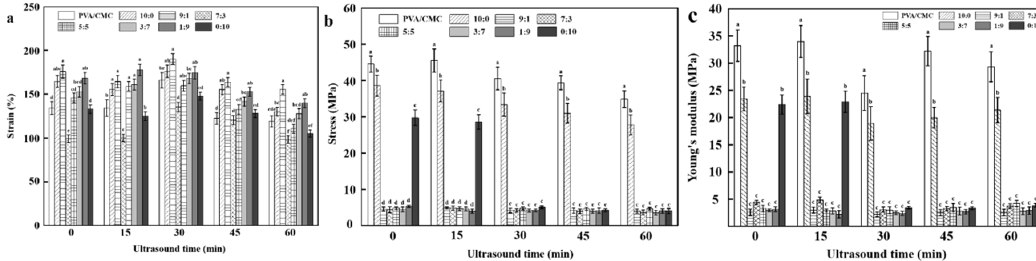
Figure 8. Strain ( a ), Stress ( b ) and Young’s modulus ( c ) of pure PVA/CMC film and PVA/CMC/ZnO NPs/ x GnP composite films under different ultrasonication times. (* p < 0.05, n =